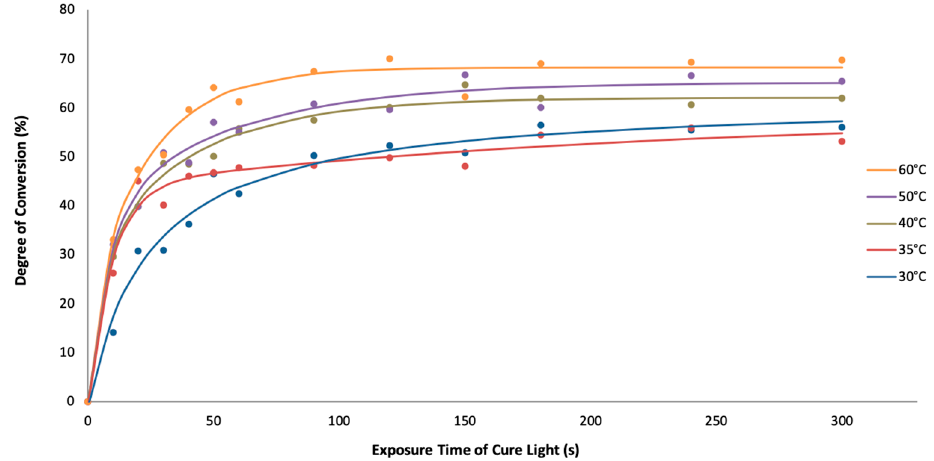
Figure 3. Conversion vs. exposure time and temperature range, bridging the nematic to the isotropic phase, in thin films similar to those used for the optical microscopy measurements in Figure 2.